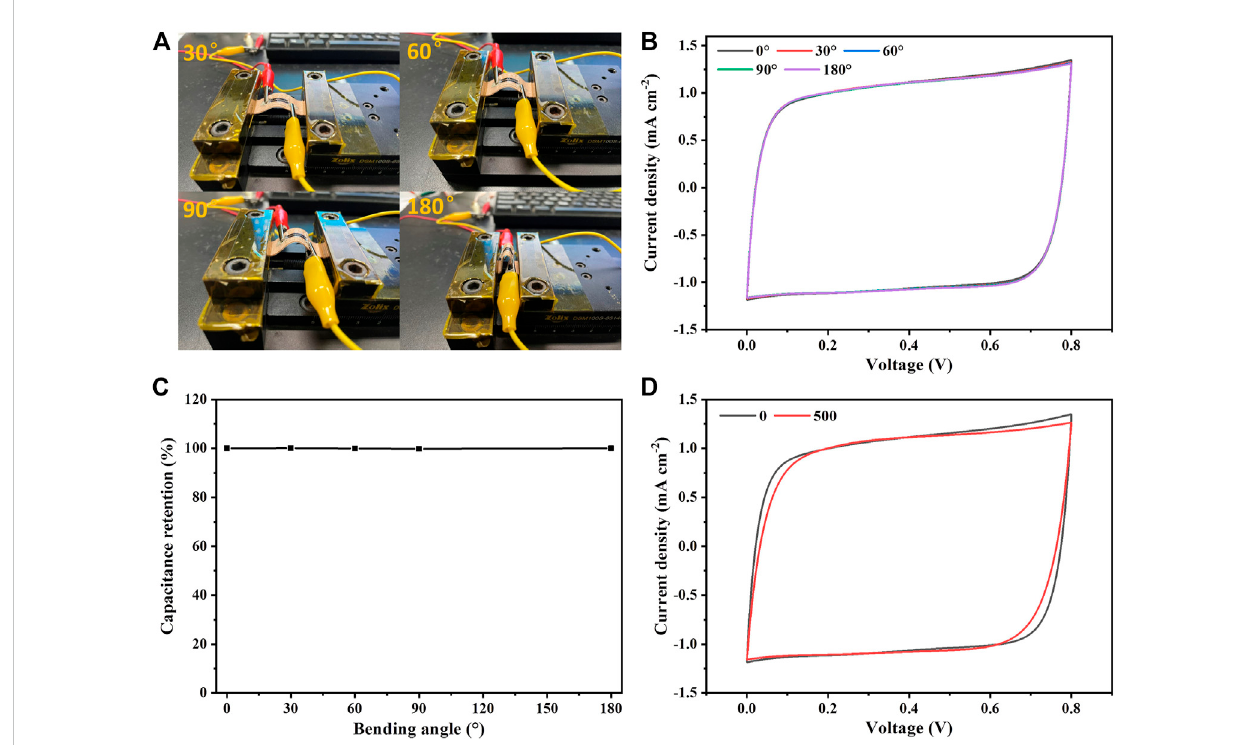
FIGURE 6 (A) Photos of the MSC-150 under bending deformations. (B) CV curves (100 mV s − 1 ) and (C) capacitance retentions of the MSC-150 under different bending angles. (D) CV curves (100 mV s − 1 ) of the MSC-150 after 500 bending cycles.